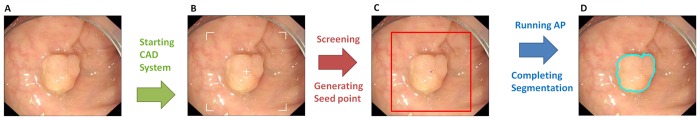
Overview of AP algorithm designed for CAD system.(A) Display screen of endoscopic diagnosis. (B) Display screen after starting the CAD system. (C) The seed placement automatic initialization base on white viewfinder in (B). (D) The segmentation result of AP.